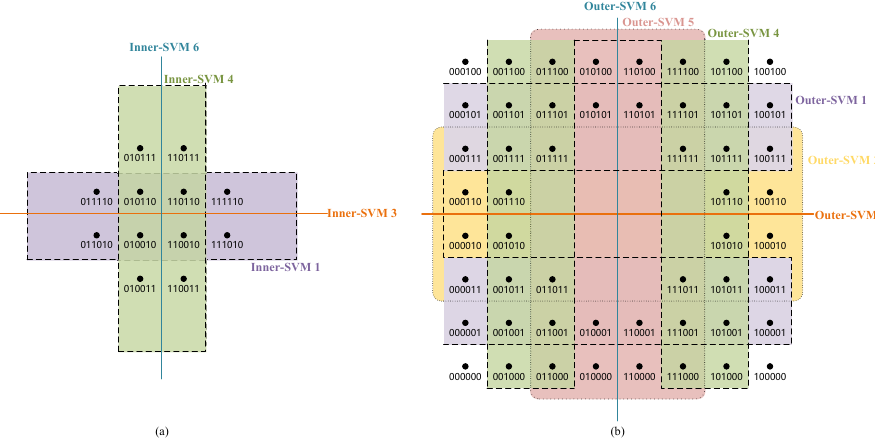
Figure 7. Classification strategy for ( a ) inner constellation points and ( b ) outer constellation